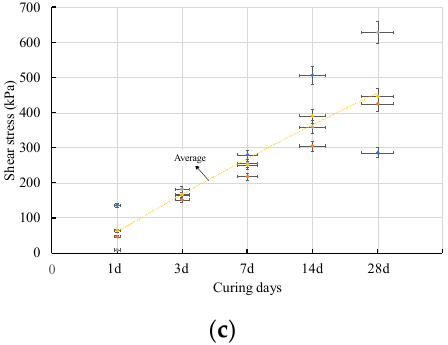
Figure 14. Average peak shear stress at different curing ages. ( a ) Shear angle of 40° . ( b ) Shear angle of 50°. ( c ) Shear angle of 60°.